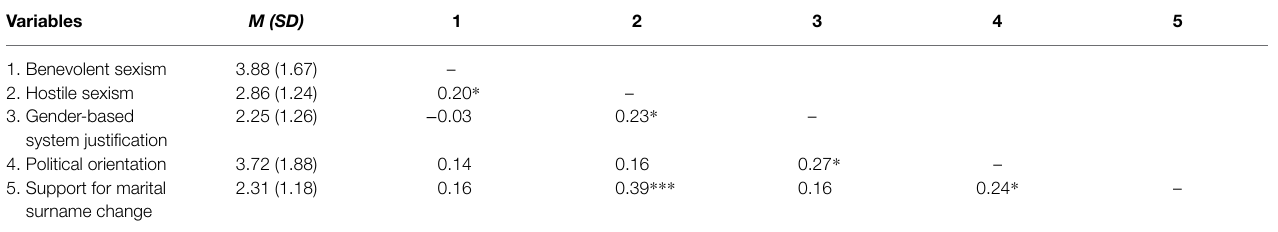
TABLE 2 | Means, SDs, and correlations among key variables (Study 2). Variables